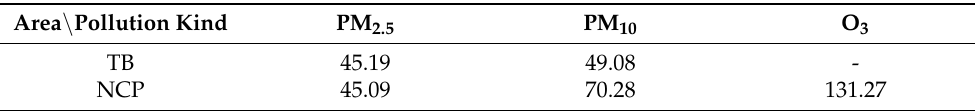
Table 1. Average concentration of pollutants in the Tarim Basin and the North China Plain from 2013 to 2018 (unit: µ g · m − 3